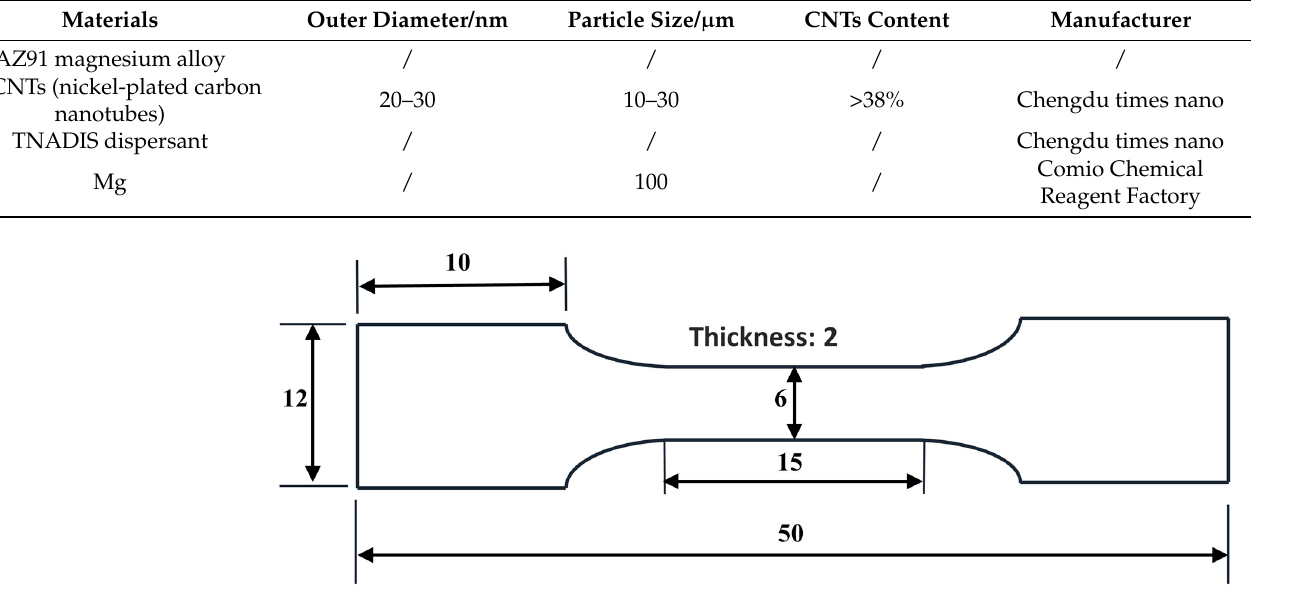
Figure 3. Tensile specimen size of Ni-CNTs/AZ91 magnesium matrix composites (unit: mm).